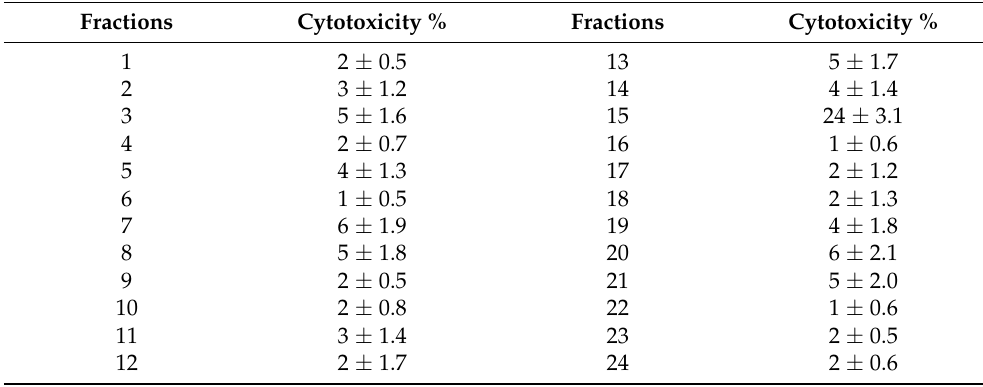
Table 1. Cytotoxic activity of peptide fractions. PBMCs were treated with fractions for 6